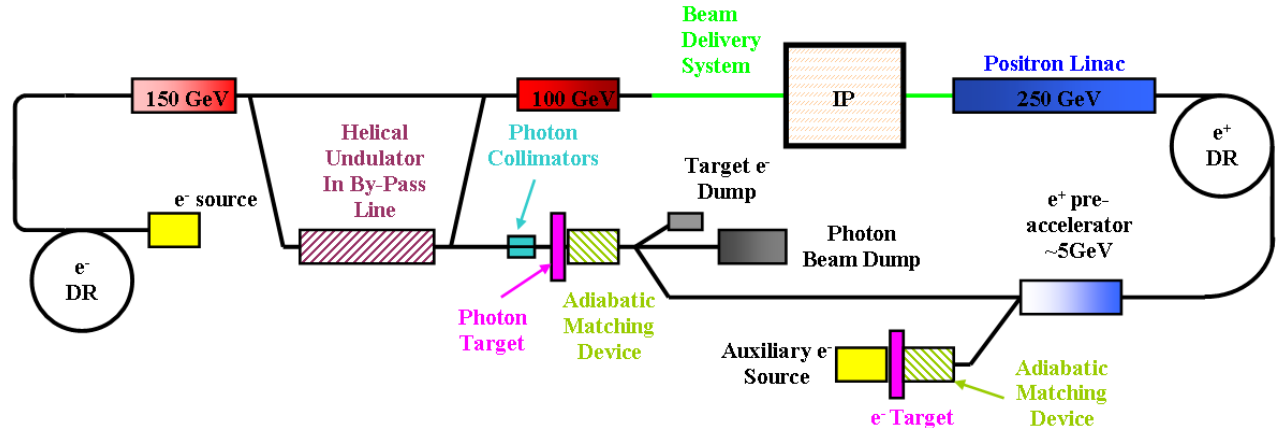
FIG. 1. (Color) ILC schematic layout with main positron source components. The undulator is placed at the 150 GeV point of the main linac in a by-pass line so that the axis of the generated photon beam is separate from the axis of the main electron beam. Photons incident on the target produce electron-positron pairs via pair production. The positrons are captured and accelerated in the adiabatic matching device and then accelerated to 5 GeV in the preaccelerator. They are then transported to the positron damping ring and then on to the main positron linac. DR stands for the damping rings and the auxiliary electron source represents a low intensity conventional positron source to be used when the undulator source is not